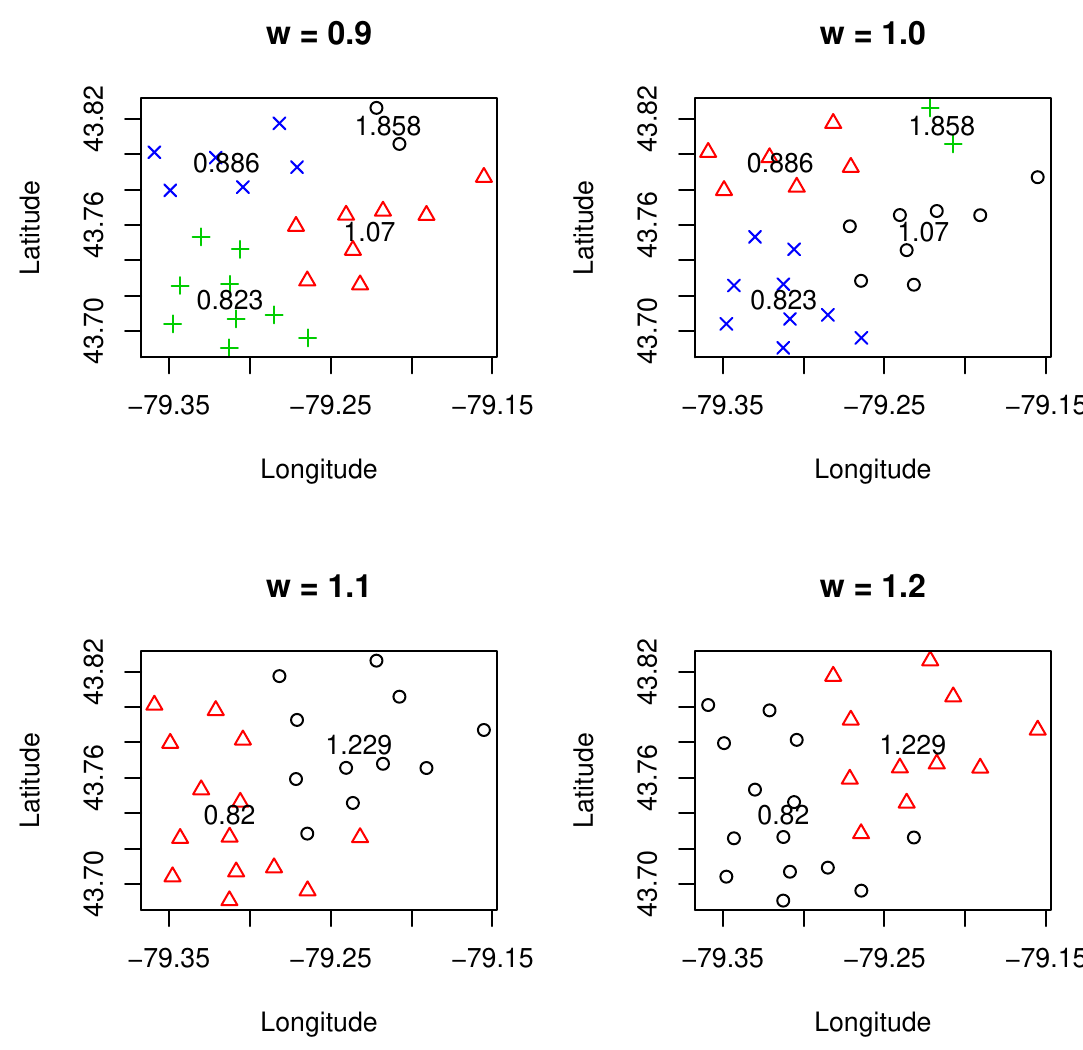
Figure 2. The weighted K -means clustering results using different values of w 1 (i.e., w 1 = 0.9, 1.0, 1.1 and 1.2, respectively) for a selected geographical area. The value indicated within each cluster represents the relativity of its loss cost to the overall average loss cost weighted by